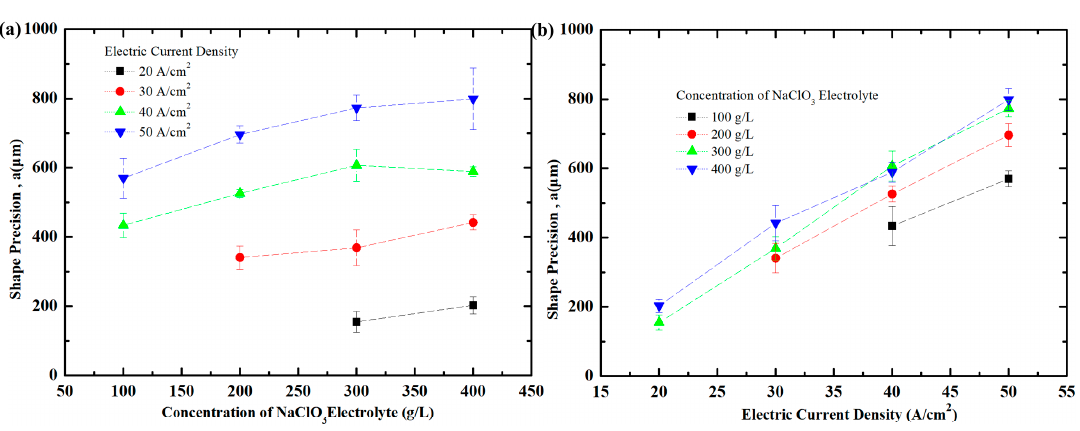
Figure 13. ( a ) Shape precision at different concentration of NaClO 3 electrolyte; ( b ) Shape precision at different current density under NaClO 3 electrolyte.